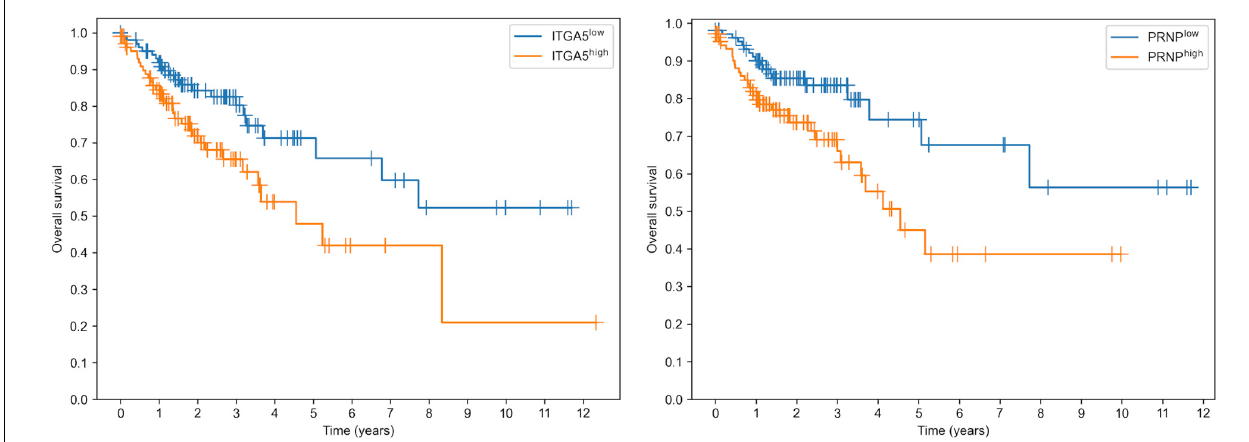
FIGURE 5 | Prognostic value of ITGA5 and PRNP genes in The Cancer Genome Atlas Colon Adenocarcinoma cohort.